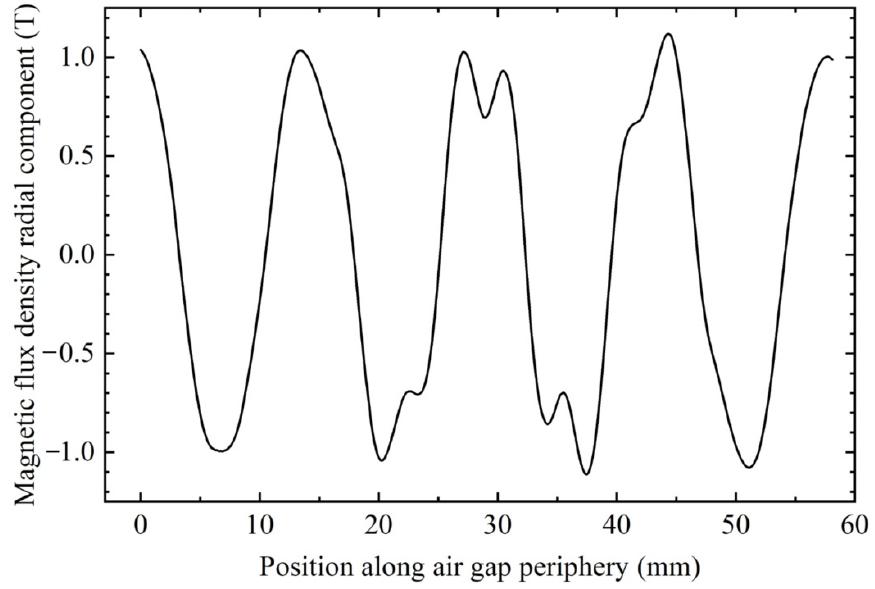
Figure 20. Relationship between the radial component of air-gap flux and the peripheral position of airgap.